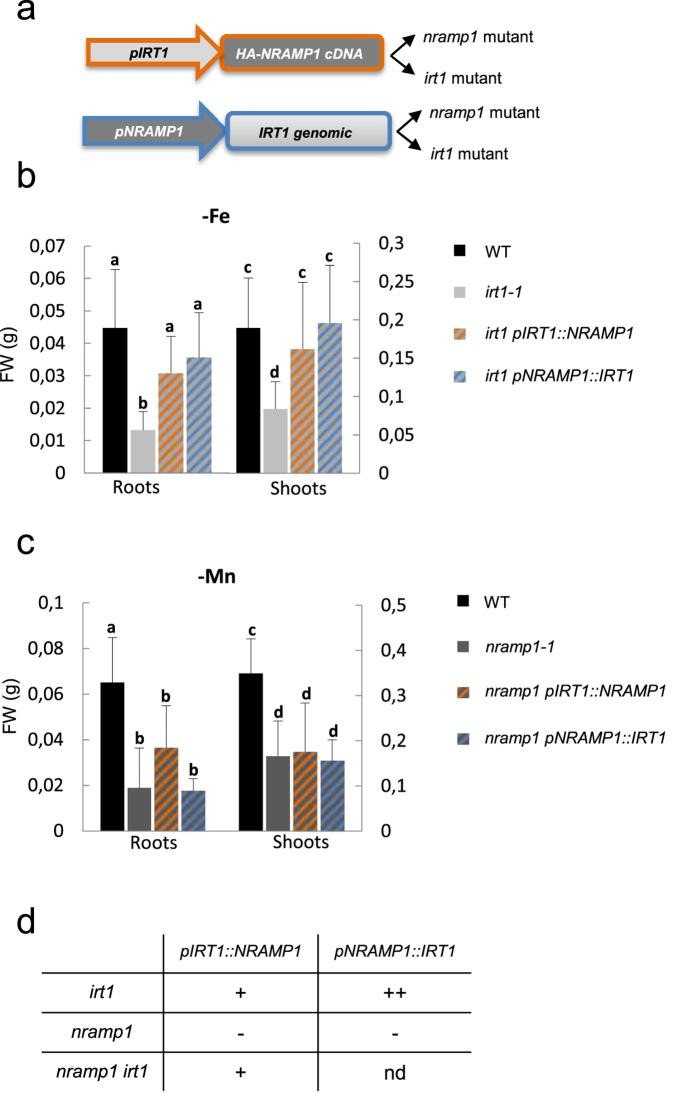
Complementation of nramp1-1 and irt1-1 mutants by promoter swap constructs.(a) Promoter swap design. (b) Complementation of irt1-1 hypersensitivity to iron deficiency (-Fe) by promoter swap constructs was assessed by measuring the fresh weight (FW) of roots and shoots of 3 week-old plants grown 2 weeks in standard hydroponic conditions and one more week with no added iron. (c) Complementation of nramp1-1 hypersensitivity to manganese deficiency (-Mn) by promoter swap constructs was assessed by fresh weight (FW) measurement of roots and shoots of 3 week-old plants grown in hydroponic conditions with no added manganese. In (b) and (c) Mean ± sd (n = 6 to 12 plants). Values that are not statistically different are marked with the same letter (ANOVA, α risk 5%). (d) Summary of the complementation results from (b), (c) and Supplementary Fig. S6. (++) optimal complementation, (+) good complementation, (−) absence of complementation, (nd) not determined.